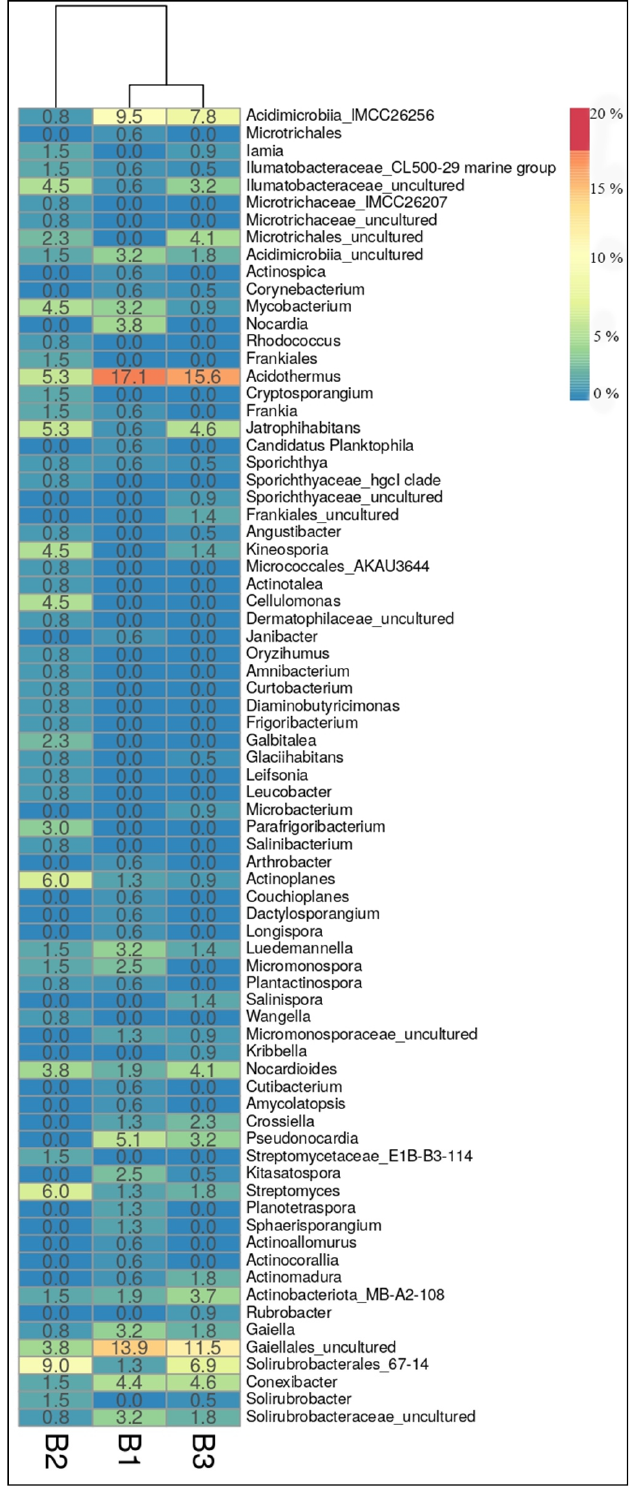
Figure 5. Taxonomic classification of genera within the Actinobacteriota phylum in libraries of 16S rRNA gene fragments (according to SILVA) derived from samples of alluvial brown soil (B1), leaf litter (B2) and soil from epiphyte baskets (B3) collected from the territory of the Pu Hoat Nature Reserve. The numbers in the diagram indicate the percentage of the number of sequences in the library within the Actinobacteriota phylum in each sample